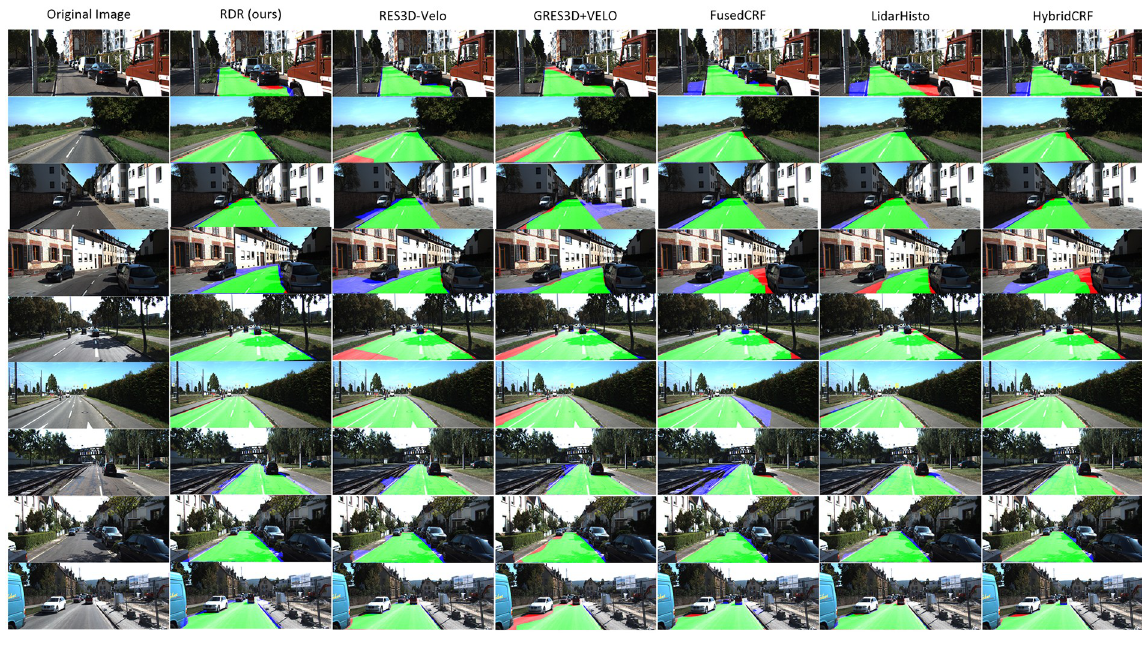
Fig 8. Visual results comparison.